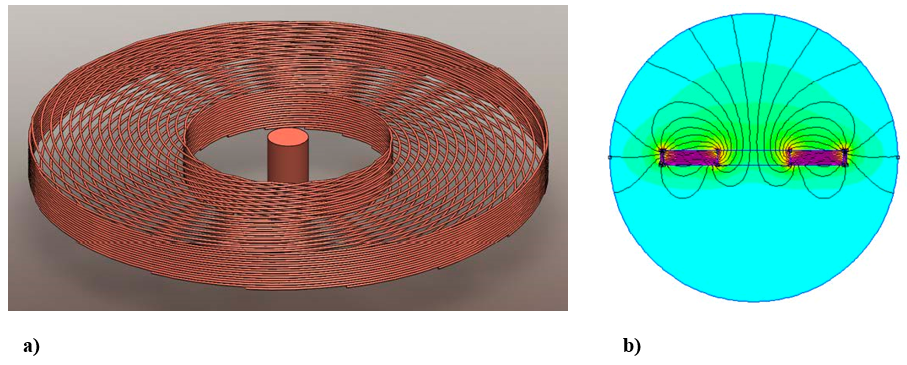
Figure 28. ( a ) A proposed Halbach array-based design for a drive coil and ( b ) computed flux contours for the proposed configuration (from [93]; reproduced with permission of the